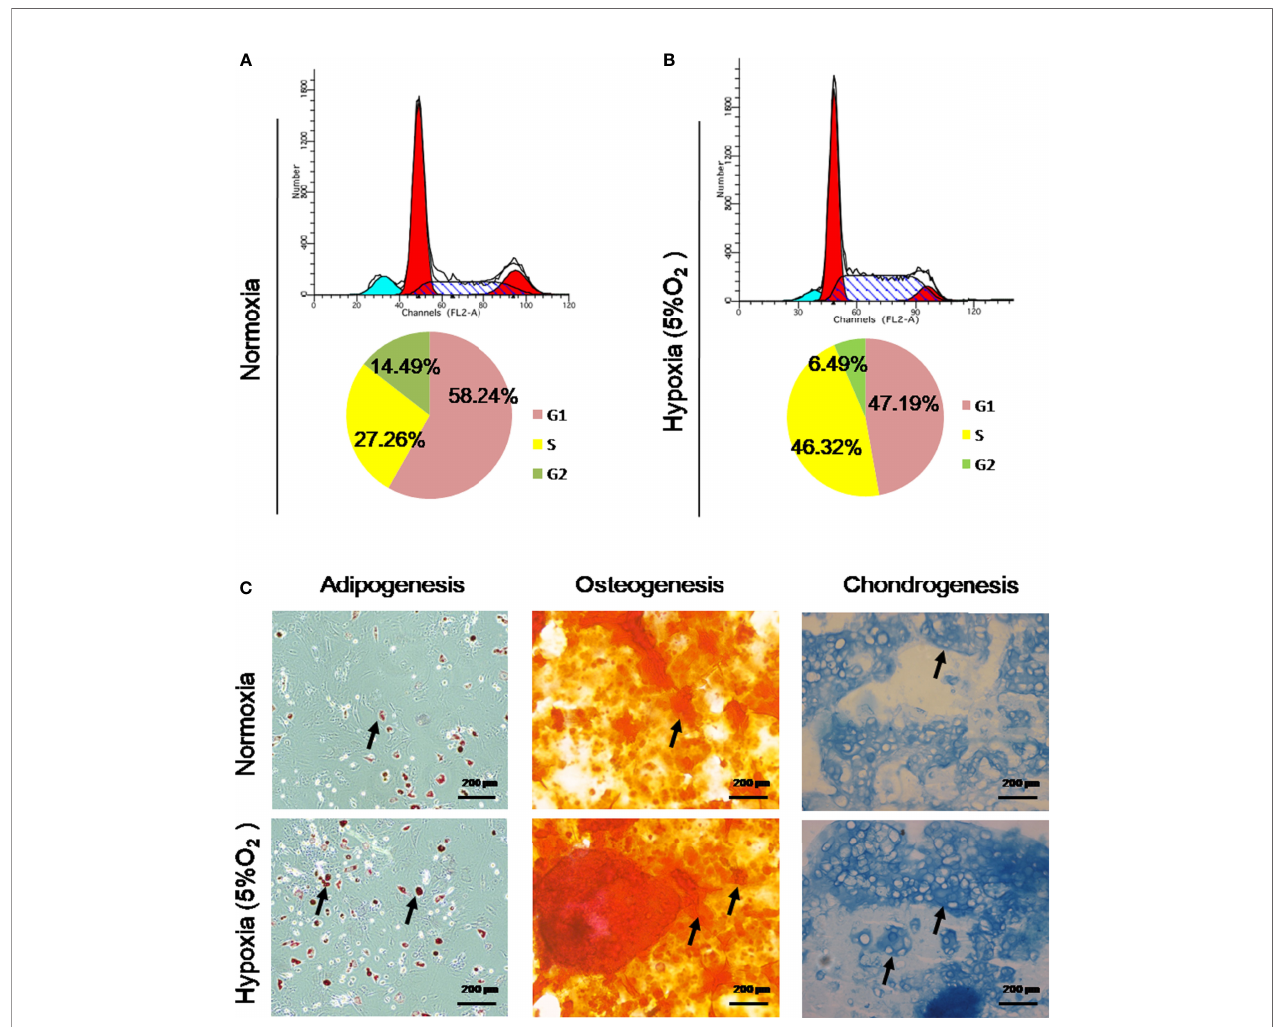
FIGURE 3 | Hypoxia promoted cell cycle transition and maintained the trilineage differentiation capacity of rPBMSCs. (A, B) Hypoxia promoted cell cycle transition, as determined by fl ow cytometry. (C) rPBMSCs were cultured under normoxia and hypoxia (5% O 2 ) for chondrogenic differentiation, osteogenic differentiation, and adipogenic differentiation for 21 days. Magni fi cation, 200×. Arrows indicate lipid droplets, proteoglycans, and calcium nodules. rPBMSCs, rat peripheral blood- derived mesenchymal stromal